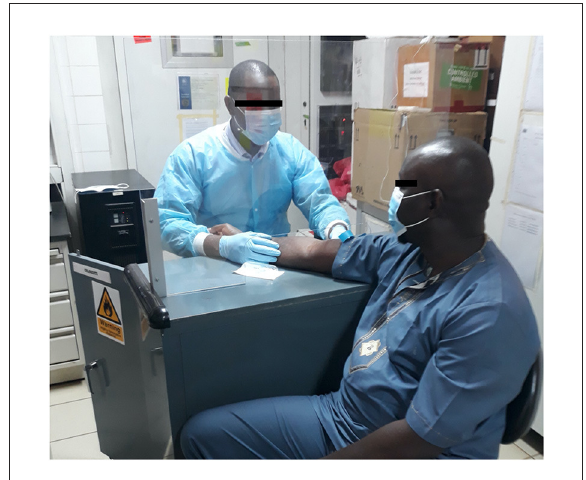
FIGURE1 Study staff demonstrating PPE and locally manufactured barriers used at study sites in response to the COVID-19